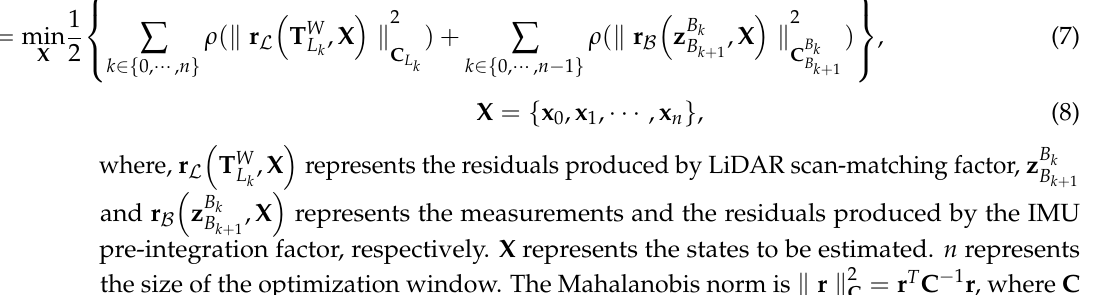
Figure 3. Illustration of the sliding window during the proposed LC optimization.